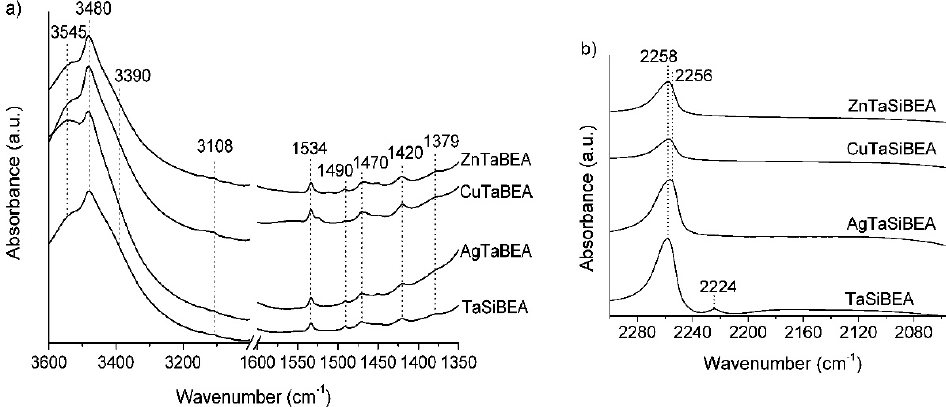
Figure 8. FTIR spectra of ( a ) pyrrole and ( b ) CDCl 3 adsorption over the Ta-BEA and MTa-BEA catalysts where M is Ag, Cu, or Zn. Reprinted with permission from [65]. Copyright 2017 American Chemical Society.